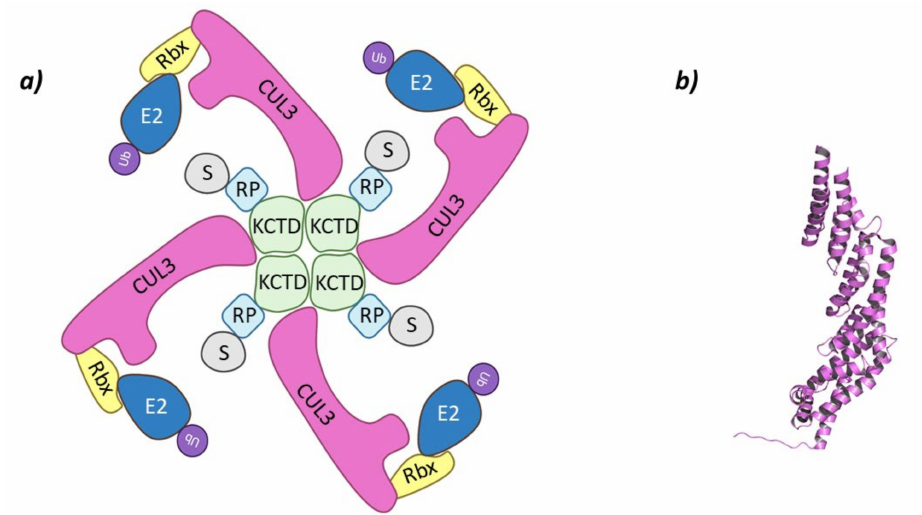
Figure 3. Cul3-KCTD. ( a ) Schematic representation of the assembly of the Cul3-KCTD E3 ligase adapted from Correale S. et al. [46]: adaptor protein KCTD in green, Recognition Protein (RP) in light blue, Substrate protein (S) in grey, Cullin-3 (Cul3) in magenta, Ring Box Protein (Rbx) in yellow, E2 ligase (E2) in dark blue, and ubiquitin (Ub) in purple. ( b ) 3D representation of the incomplete Cullin-3 as found in PDB code